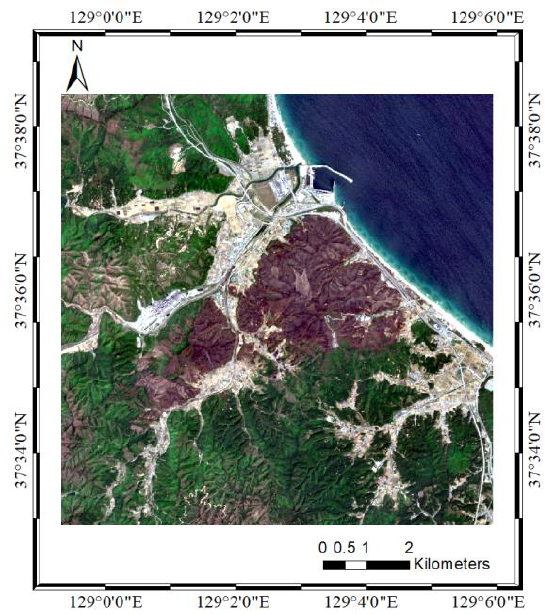
Figure 1. Location of study site (Sentinel-2A image captured